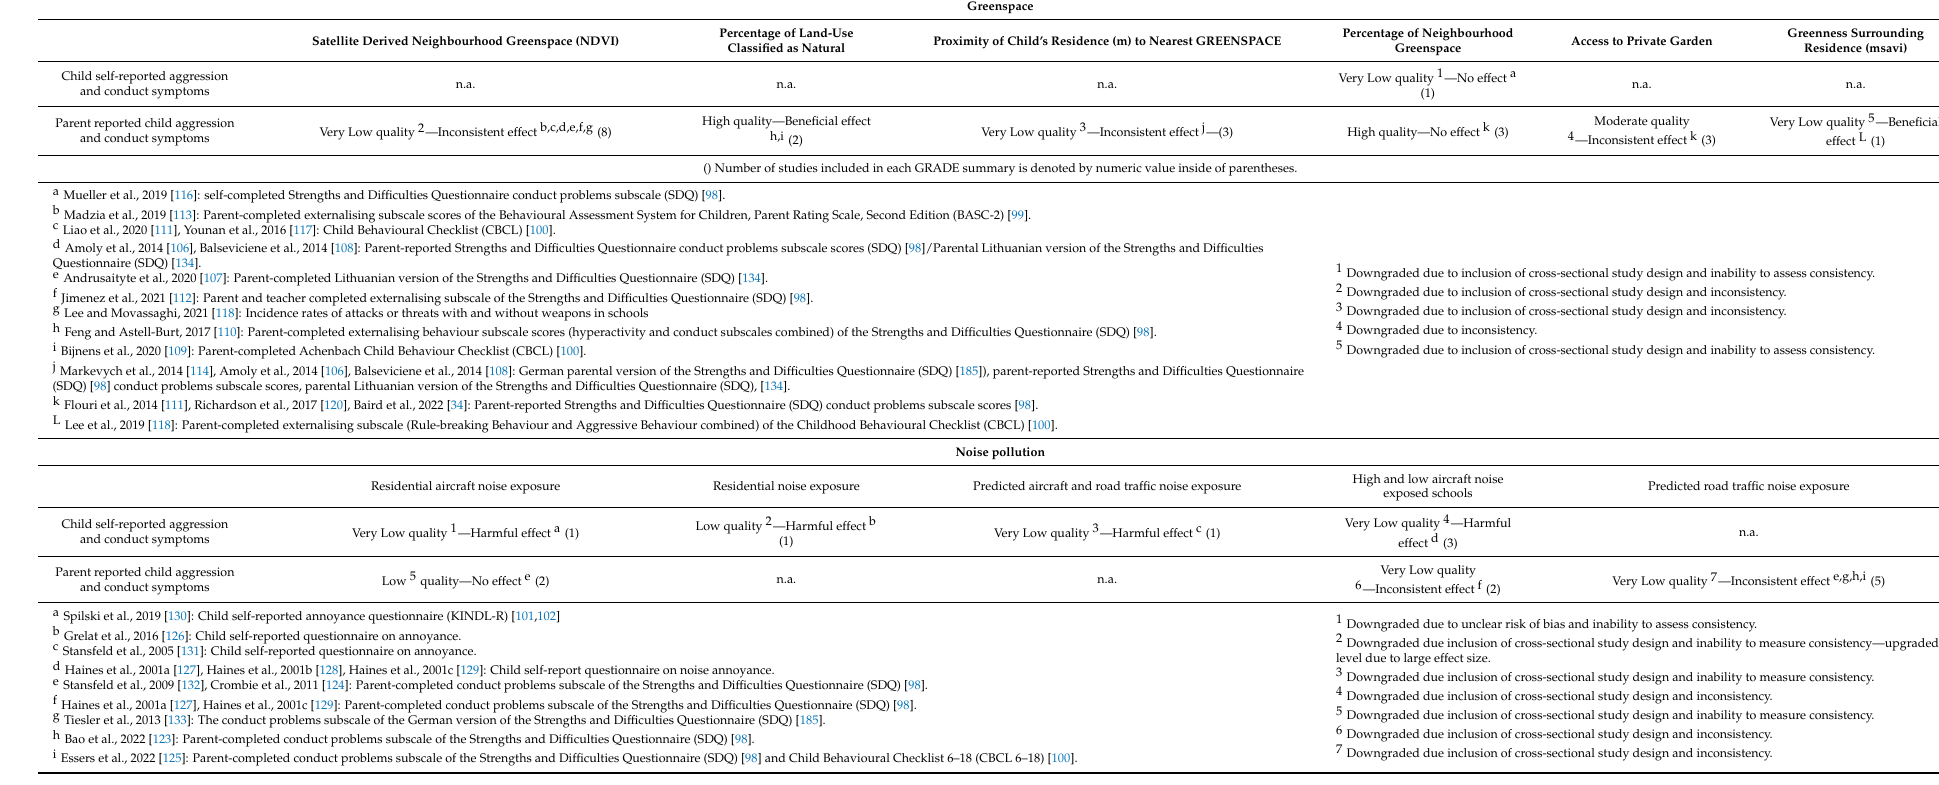
Table 3. GRADE summary of quality of evidence for typically developing